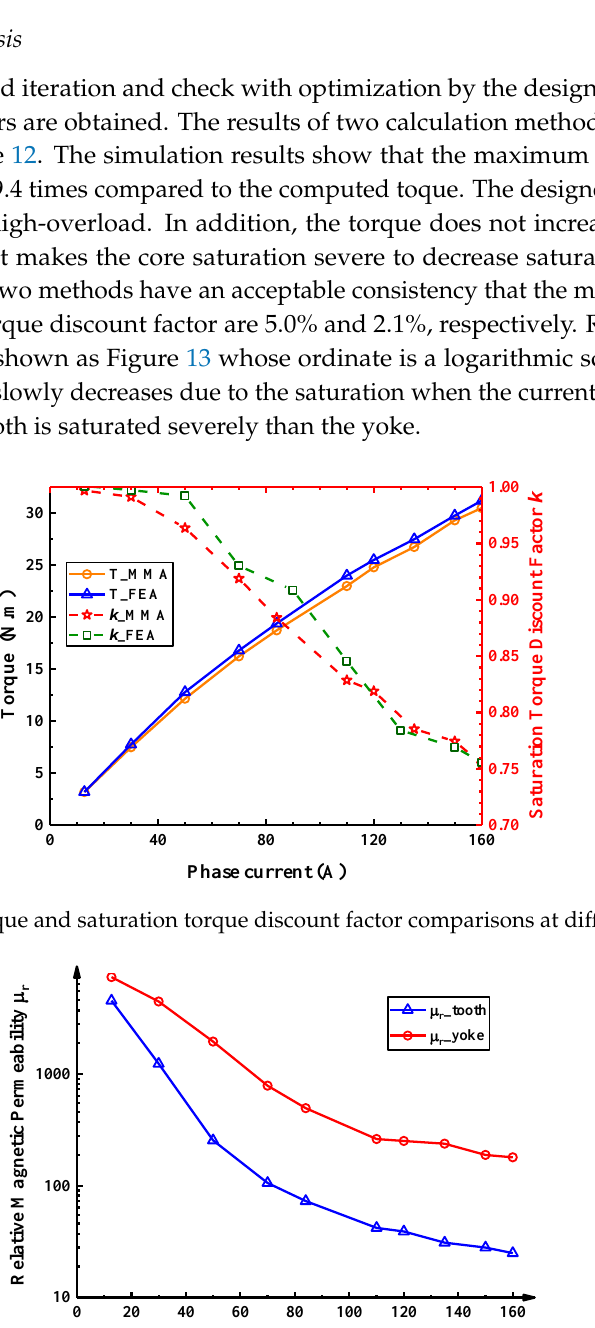
Figure 11. Magnetic density cloud map when armature current is 150 A.